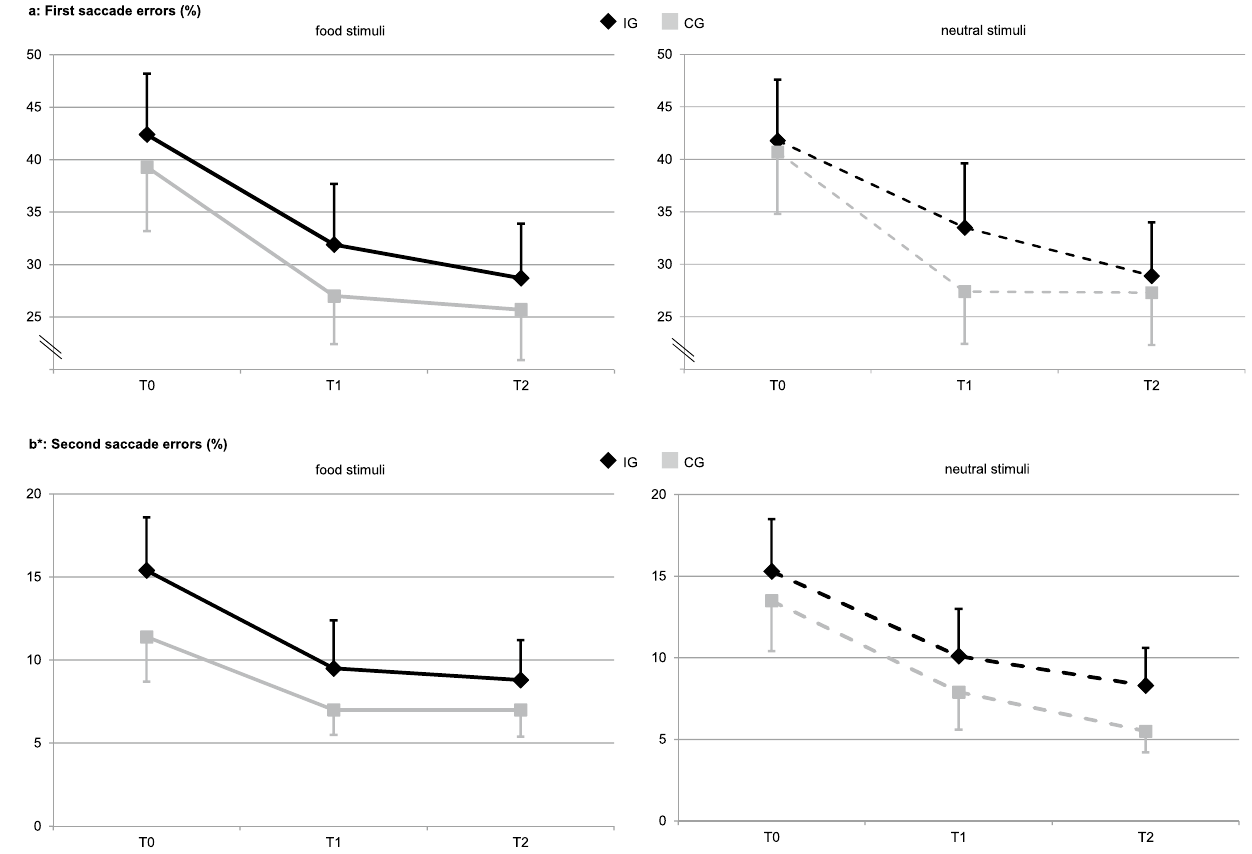
Figure 4. Eye tracking data of the modified antisaccade paradigm. Panel (a) : M (SE) of the first saccade errors (%), and Panel (b) : M (SE) of the second saccade errors (%) for food and neutral stimuli by treatment group (IG, CG) and measurement point (T0, T1, T2). Significant effects after Bonferroni correction with p < .025: in panel (a) , there is overall a significant time effect with p < .001. In IG, this effect was significant at T2 vs.